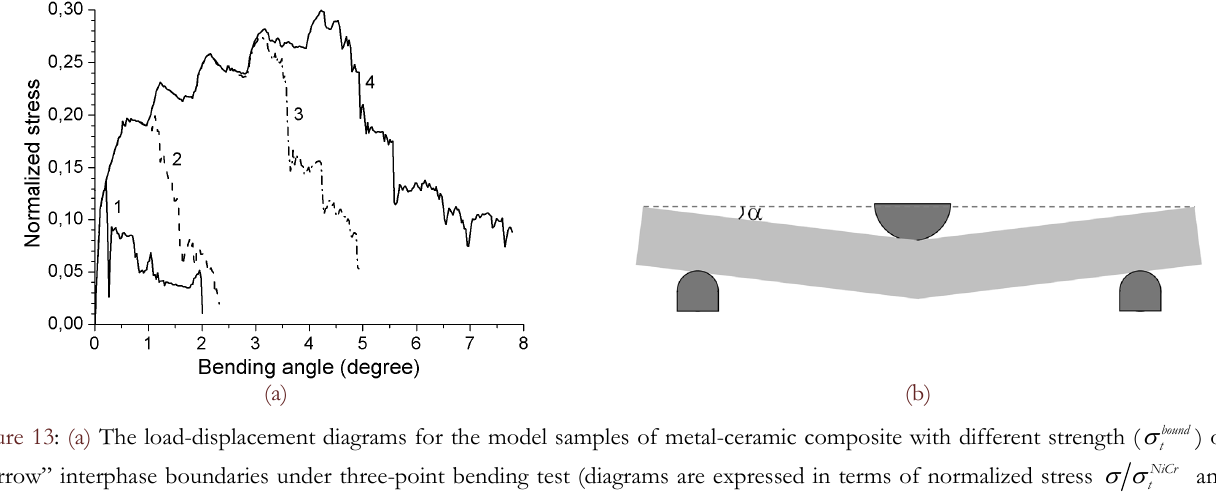
Figure 13: (a) The load-displacement diagrams for the model samples of metal-ceramic composite with different strength ( bound “narrow” interphase boundaries under three-point bending test (diagrams are expressed in terms of normalized stress NiCr  (4); (b) scheme for definition of bending angle  . Results bending angle  ): 0.5 NiCr t presented hereinafter correspond to the loading velocity of V = 0.4 m/s. load